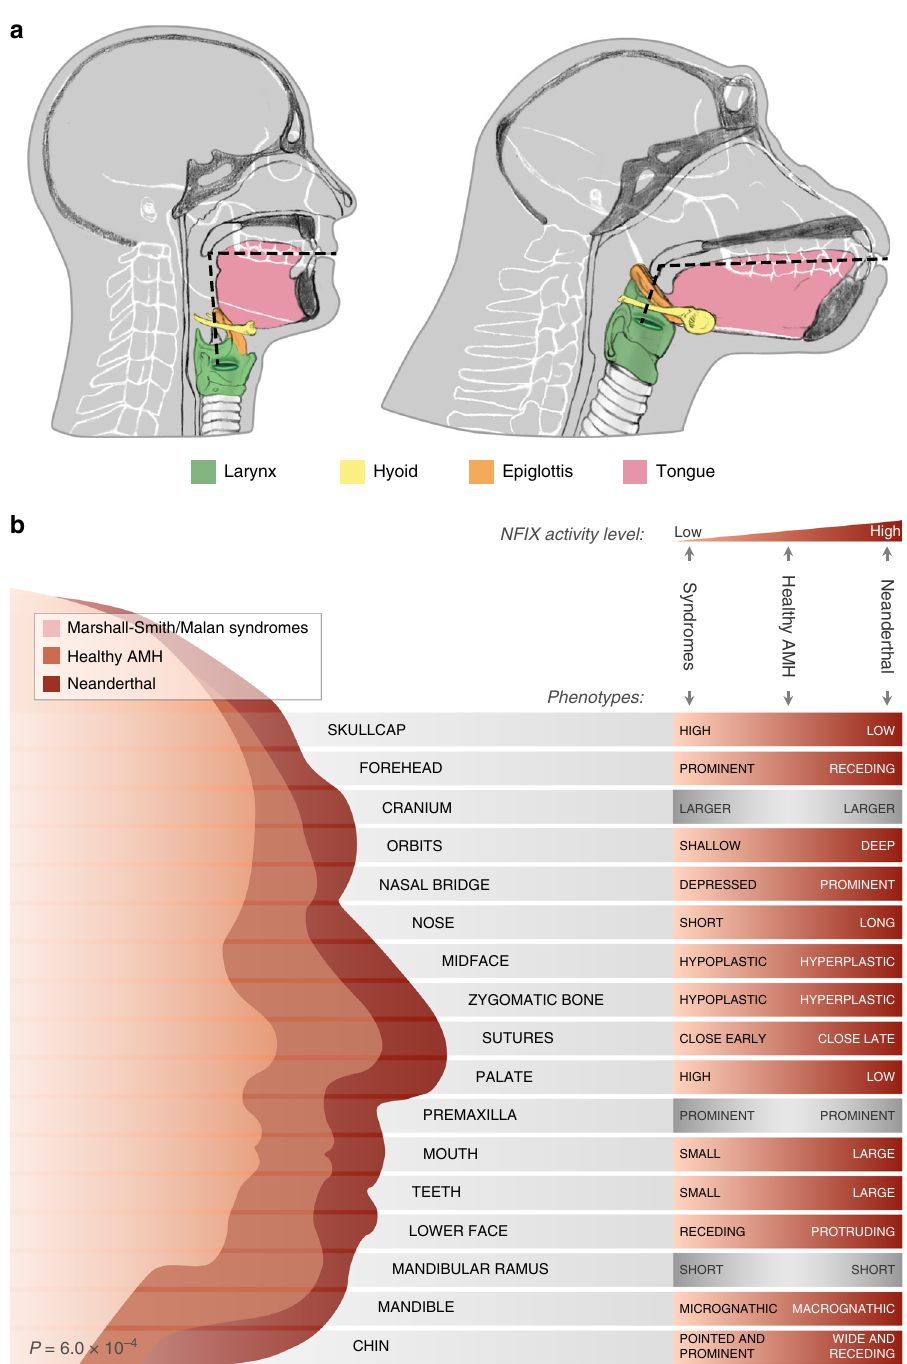
Fig. 6 NFIX down-regulation is associated with modern human-derived traits. a Vocal anatomy of chimpanzee and AMH. The vocal tract is the cavity from the lips to the larynx (marked by dashed lines). In AMHs, the fl attening of the face together with the descent of the larynx led to approximately 1:1 proportions of the horizontal and vertical portions of the vocal tract. b Craniofacial features of the Neanderthal, healthy AMH, and AMH with Marshall- Smith or Malan syndromes. Each box shows a phenotype that occurs in the Marshall-Smith/Malan syndromes (i.e., when NFIX is partially or completely inactive). The righthand side of each box shows the observed phenotypes of individuals with the syndromes (left), healthy AMHs (middle) and Neanderthals (right). In most phenotypes, the observed phenotypes match the expected phenotypes based on NFIX expression. Binomial test P -value is